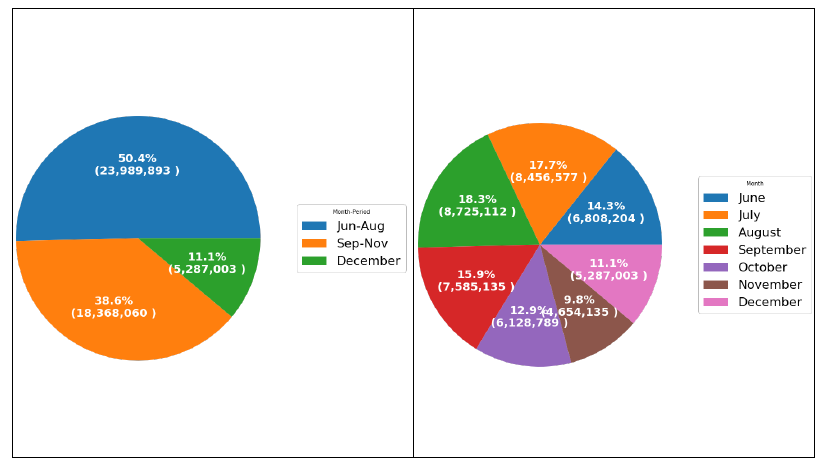
Figure 3. Monthly consumption in kWh.